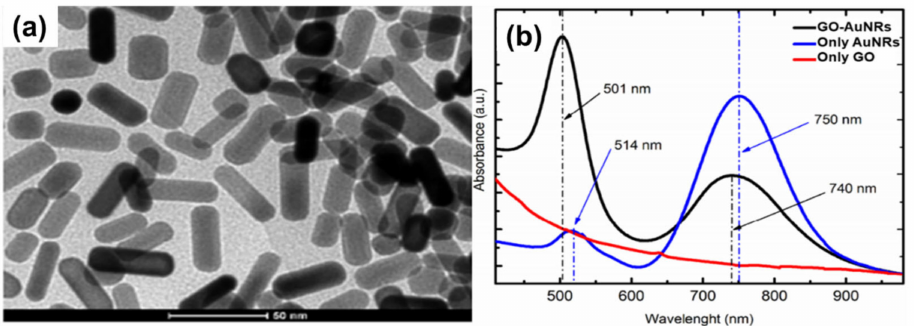
Figure 6. ( a ) TEM images of the GO–AuNRs (scale bars: 50 nm). ( b ) UV-Vis spectrum of the comparison of GO–AuNRs, AuNRs, and GO. Adapted from [119], with permission from RSC advances, 2011.